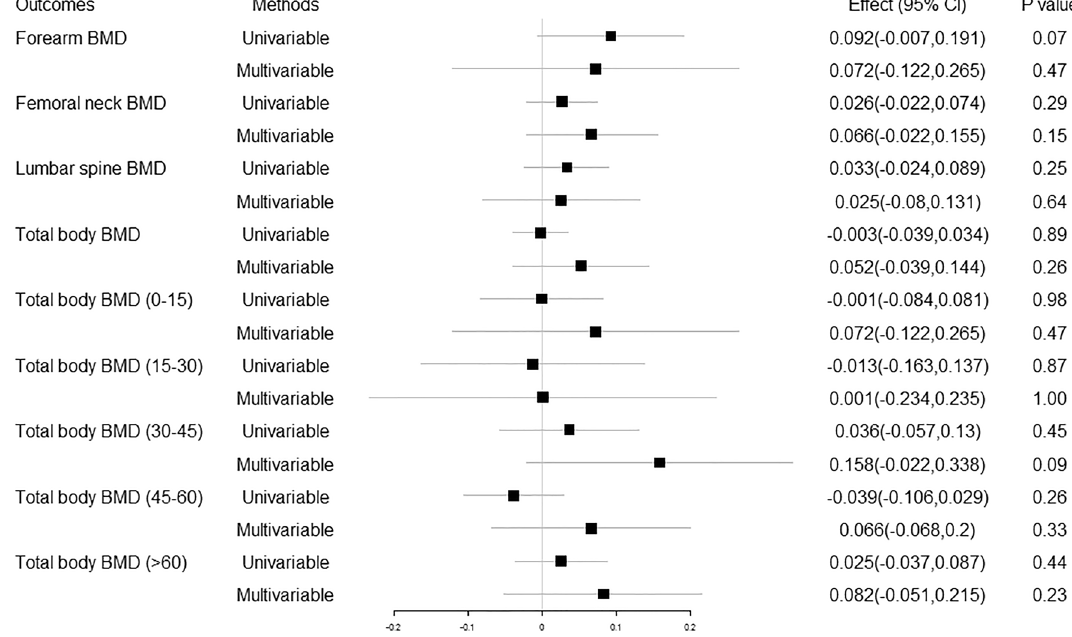
Figure 4. Univariable and multivariable Mendelian randomization analysis of the causal effect of 25OHD on BMD. 25OHD 25-hydroxyvitamin D, BMD bone mineral density, Effect the combined causal effect of 25OHD on BMD, CI confidence